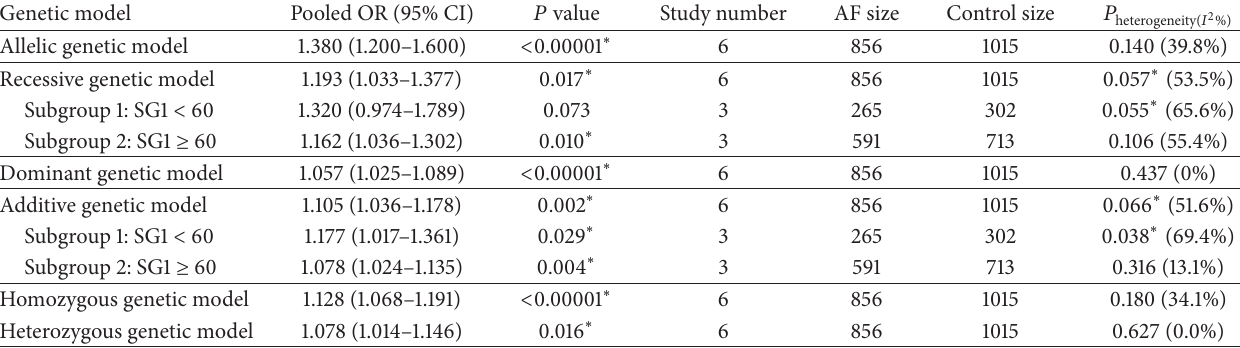
Table 2: Summary of meta-analysis of association of Mink S38G gene polymorphism and atrial fibrillation (AF) in the Chinese population.